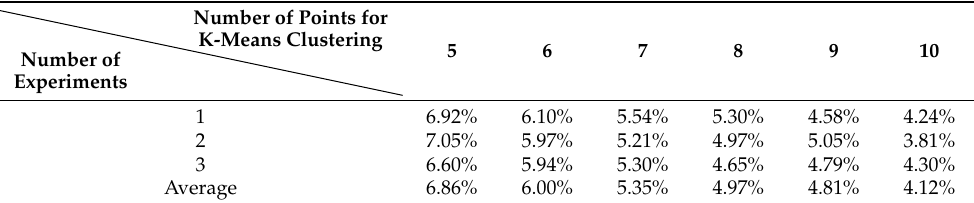
Figure 17. Comparison of triangle shape factor distribution before and after generation and opti- mization of unstructured meshes at the inlet range of the South China Sea. Table 3. Percentage of narrow triangles after optimization of the unstructured grid of the South China Sea inlet